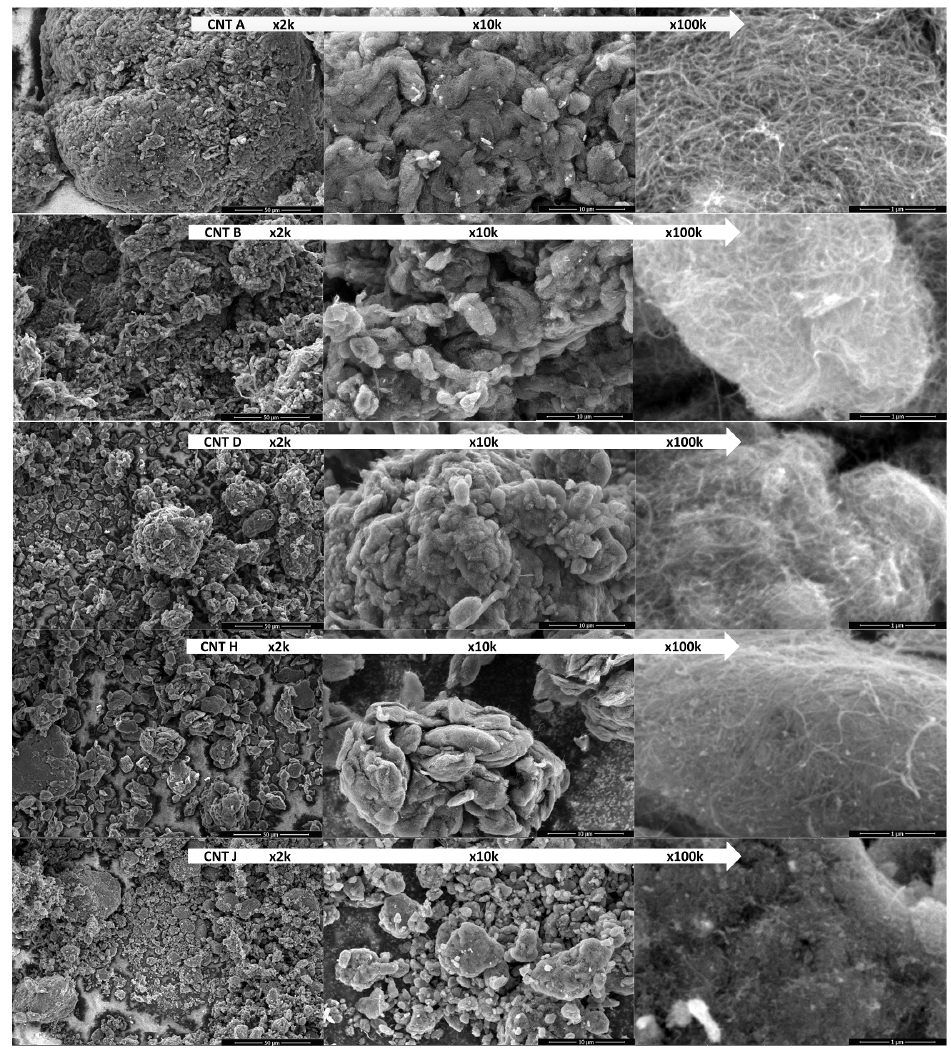
Figure 3. Comparison of selected CNM bulk material used for nanolubricant formulation: SEM images obtained at various magnification for the as-produced CNT powders.